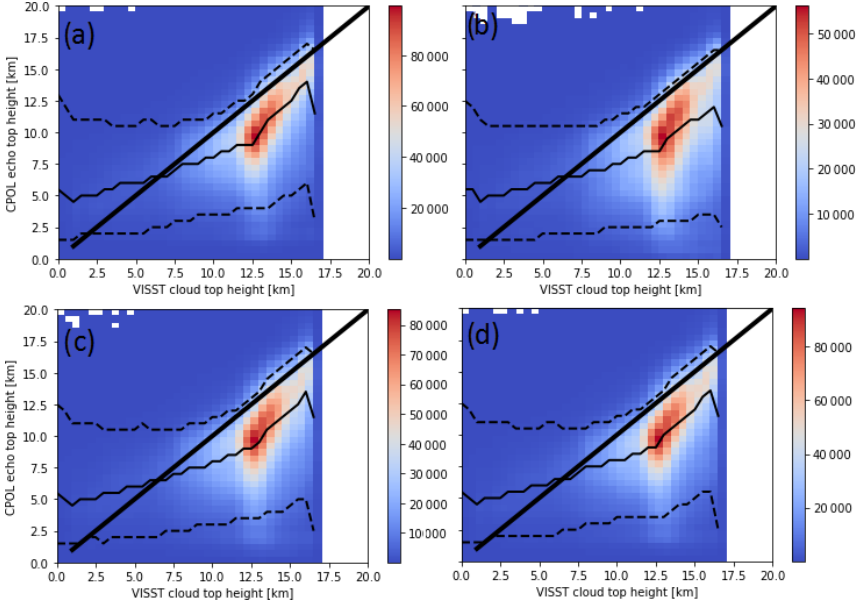
Figure 3. (a) ETH from CPOL, retrieved using a Z threshold of 5dBZ and (b) using a σ threshold of 2ms − 1 . (c) using a σ threshold of 3ms − 1 and (d) 4ms − 1 as a function of the VISST-retrieved CTH. The dashed lines represent the 5th and 95th percentiles of CPOL ETH, while the solid line represents the median of the CPOL ETH. The shading represents the number of